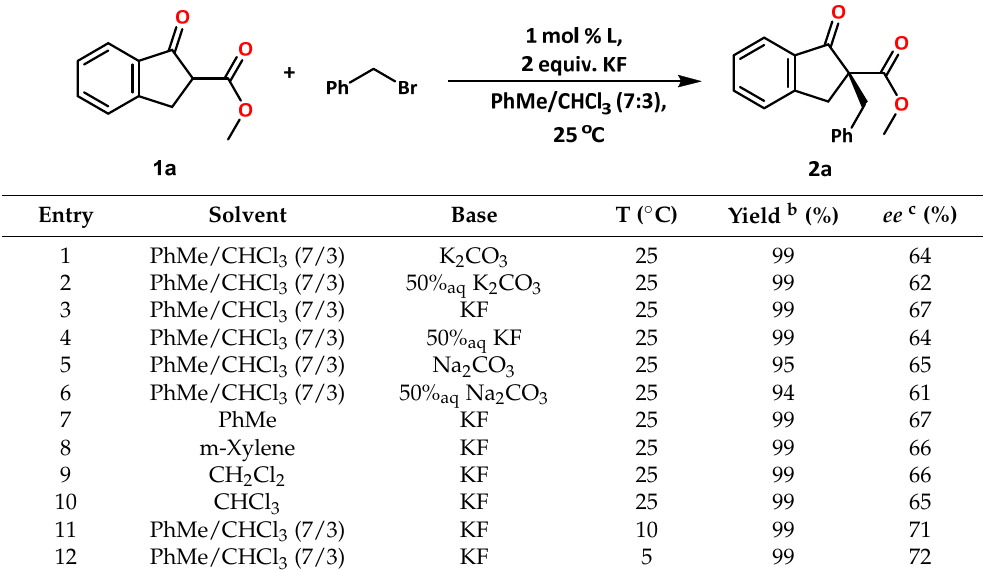
Table 2. Screening of phase-transfer catalysts A–O using substrate 1a a